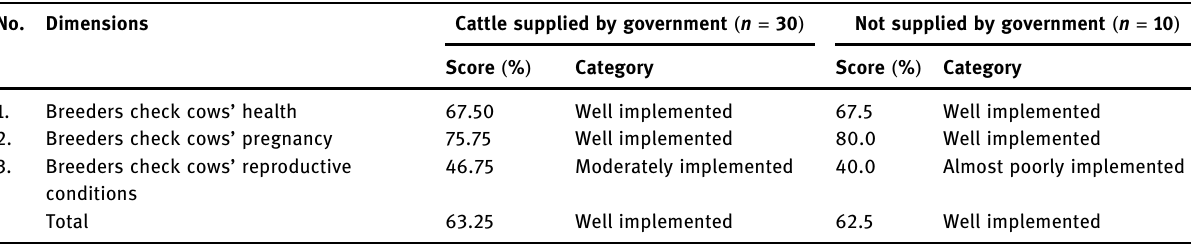
Table 4: Breeder ’ s behavior in administering integrated animal service No. Dimensions